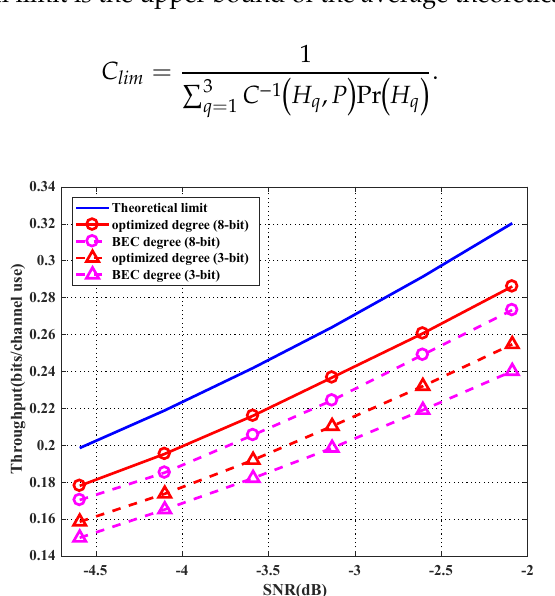
Figure 7. Bit error rate (BER) performance with the optimized profiles and benchmark profile for the cases of the three-bit quantizer and the eight-bit quantizer under different channel matrices: ( a ) 𝐇 1 , ( b ) 𝐇 2 , and ( c ) 𝐇 3 .